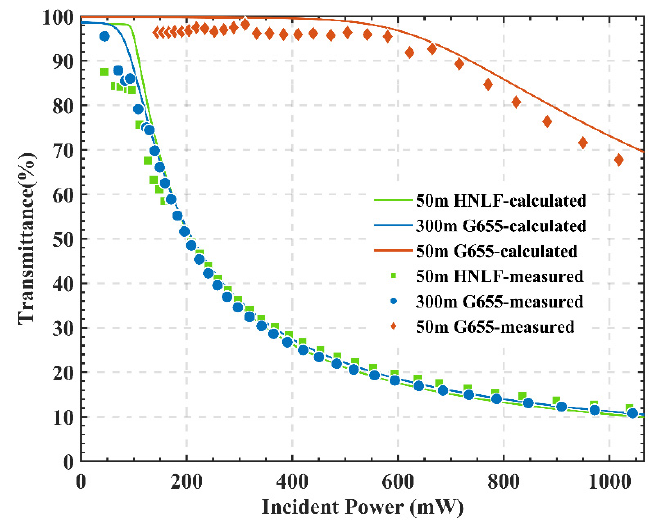
Figure 5. Transmittance of HNLF and G655 fibers.